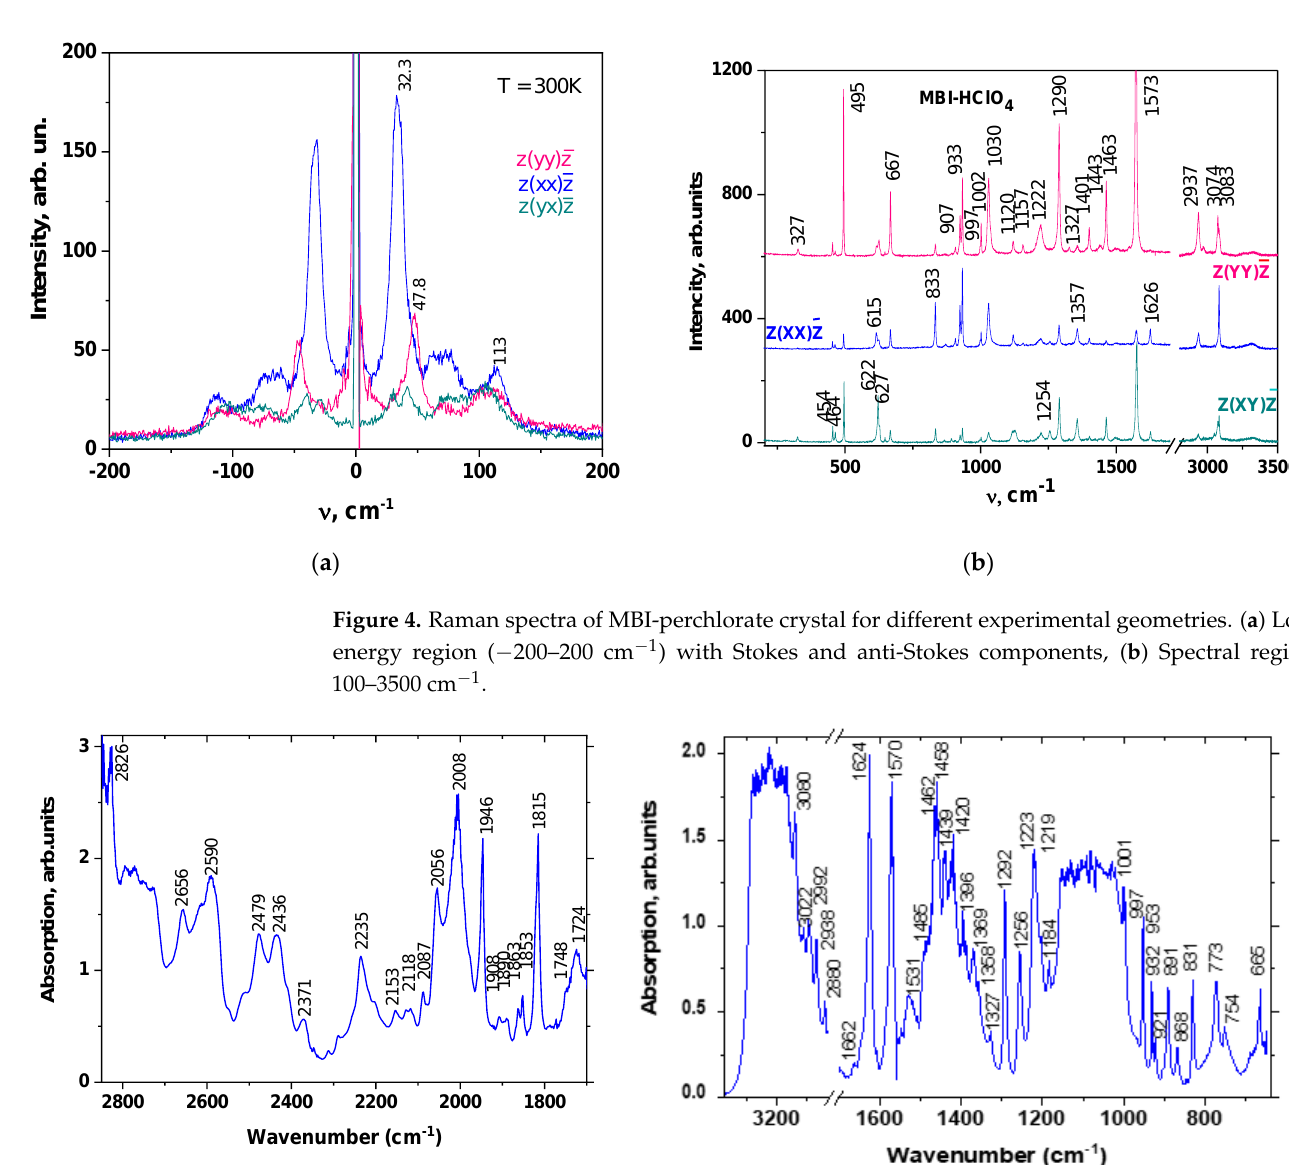
Figure 5. FTIR adsorption spectra of MBI-perchlorate crystals measured in transmission in thick ( a ) and thin ( b ) samples.